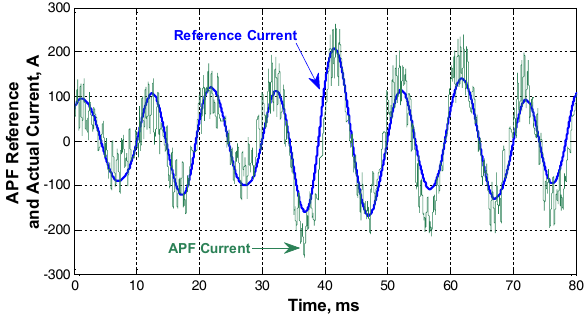
Figure 11. A sample reference current signal including 95-, 100-, and 105-Hz (deduced from field data) and corresponding current waveform injected by the APF system (simulation results).